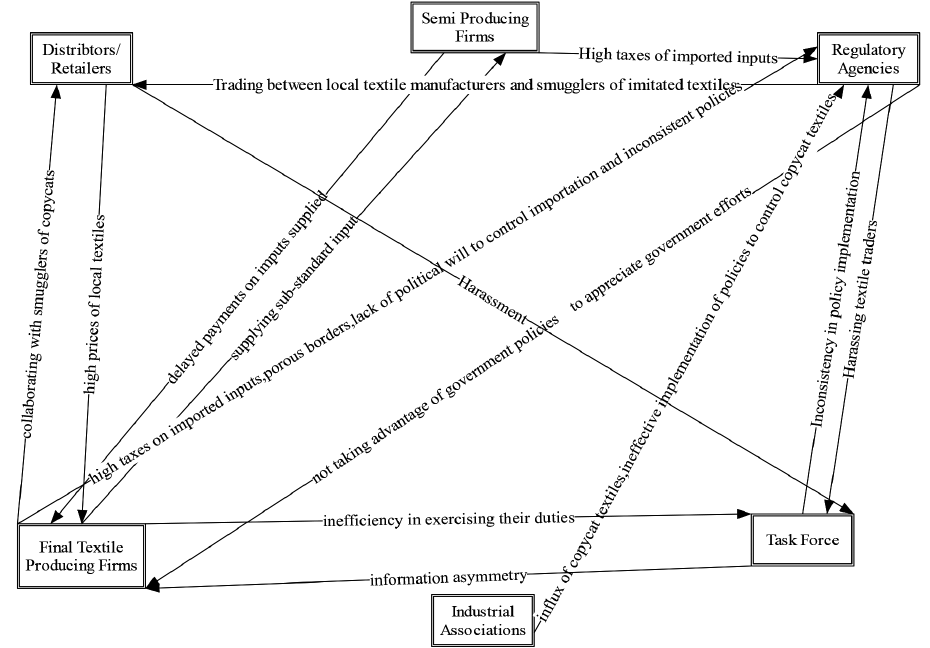
Figure 4. The blame game among stakeholders on copycat